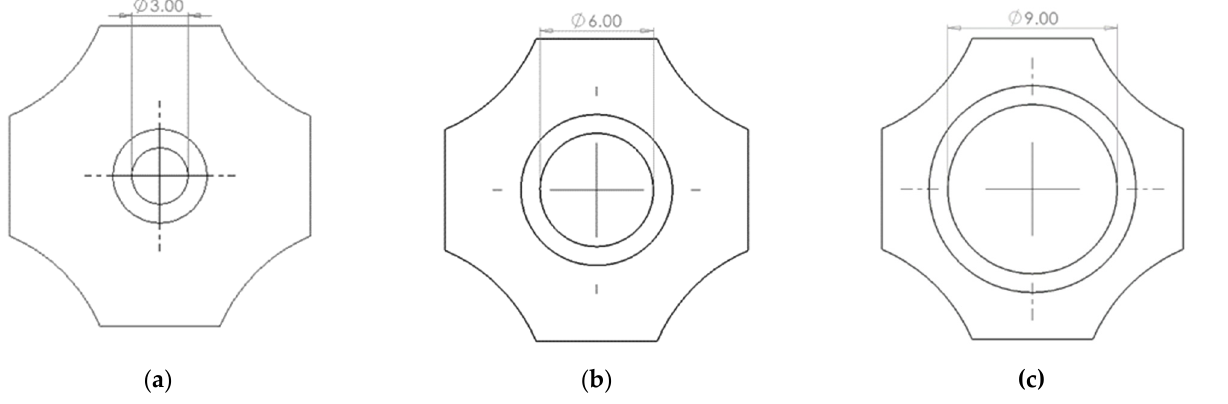
Figure 7. Top view of LCD channels for varying diameters: ( a ) d L = 3 mm; ( b ) d L = 6 mm; ( c ) d L = 9 mm.